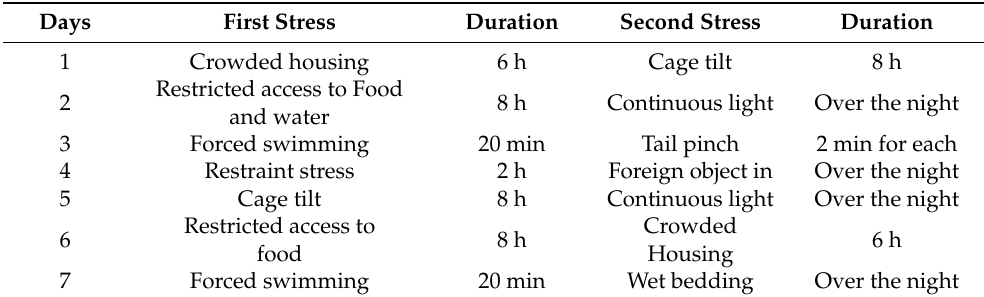
Table 1. Chronic ultra-mild stress weekly protocol .